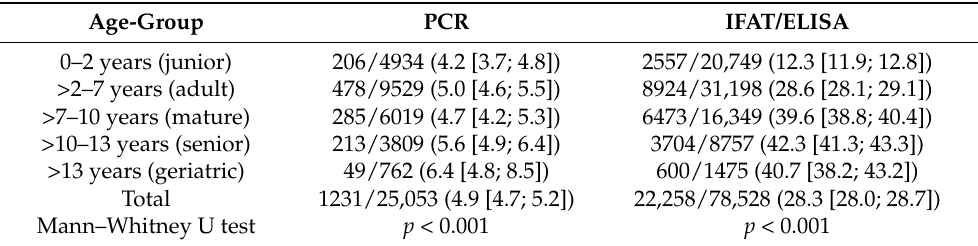
Table 1. Number of positive tests in dogs including direct and indirect detection methods for Anaplasma phagocytophilum in dogs living in Germany from 2008–2020 sorted by age ( n positive/ N total (% [95% CI lower limit; 95% CI upper